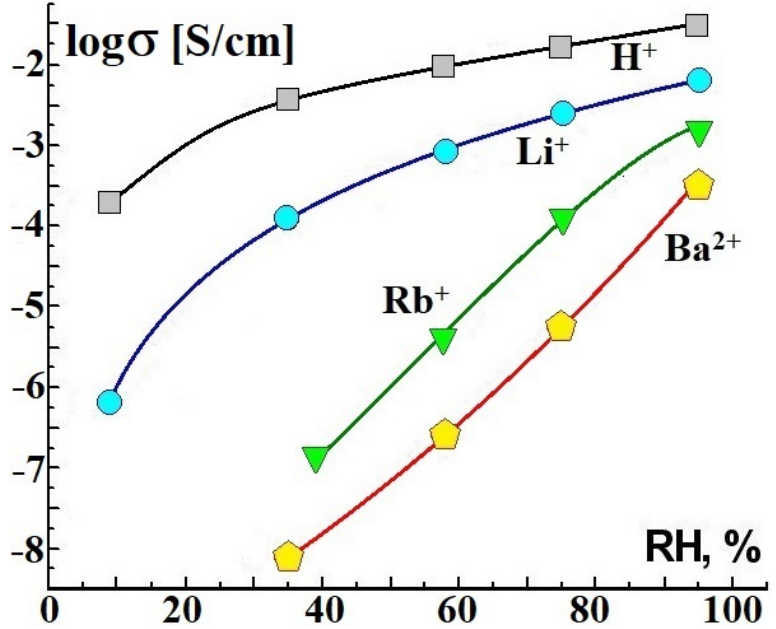
Figure 2. Dependences of ionic conductivity on relative humidity for perfluorinated sulfonic acid MF-4SK membranes in different ionic forms [101]. MF-4SK membranes in different ionic forms